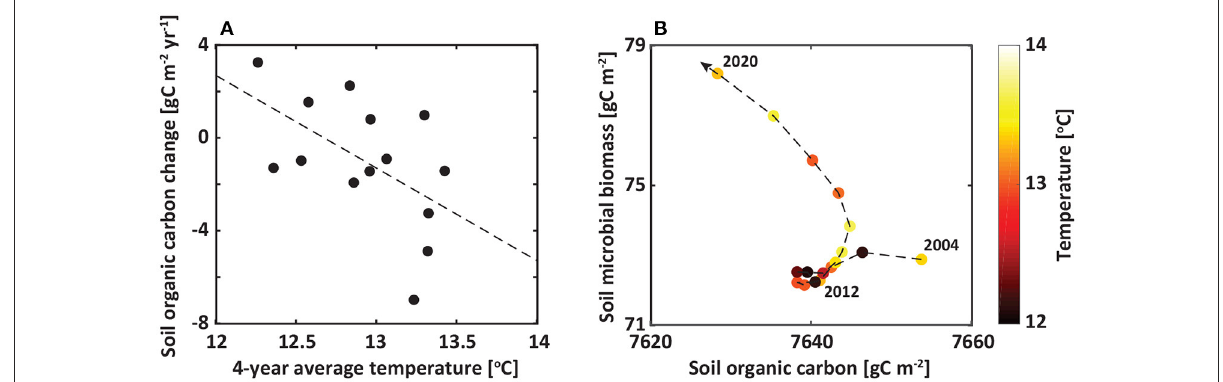
FIGURE5 Relationships between soil organic carbon, microbial biomass, and atmospheric temperature. (A) 1:1 plot for 4-year average annual temperature (x-axis) and changes in annual soil organic carbon (y-axis). (B) The relationship between annual average soil organic carbon (x-axis), soil microbial biomass (y-axis), and temperature (color bar). Soil organic carbon and microbial biomass were analyzed to a depth of 1 m.